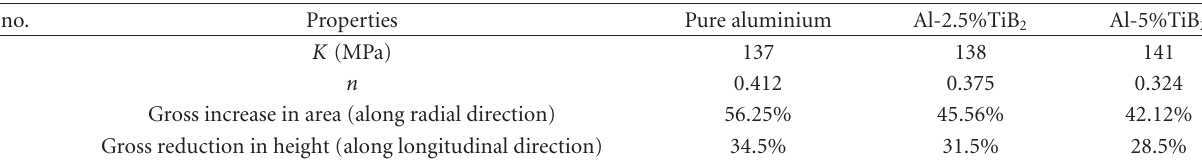
Figure 6: Elemental distribution of boron, aluminium, titanium nearby TiB 2 clusters. Table 2: Flow curve properties of composite materials.